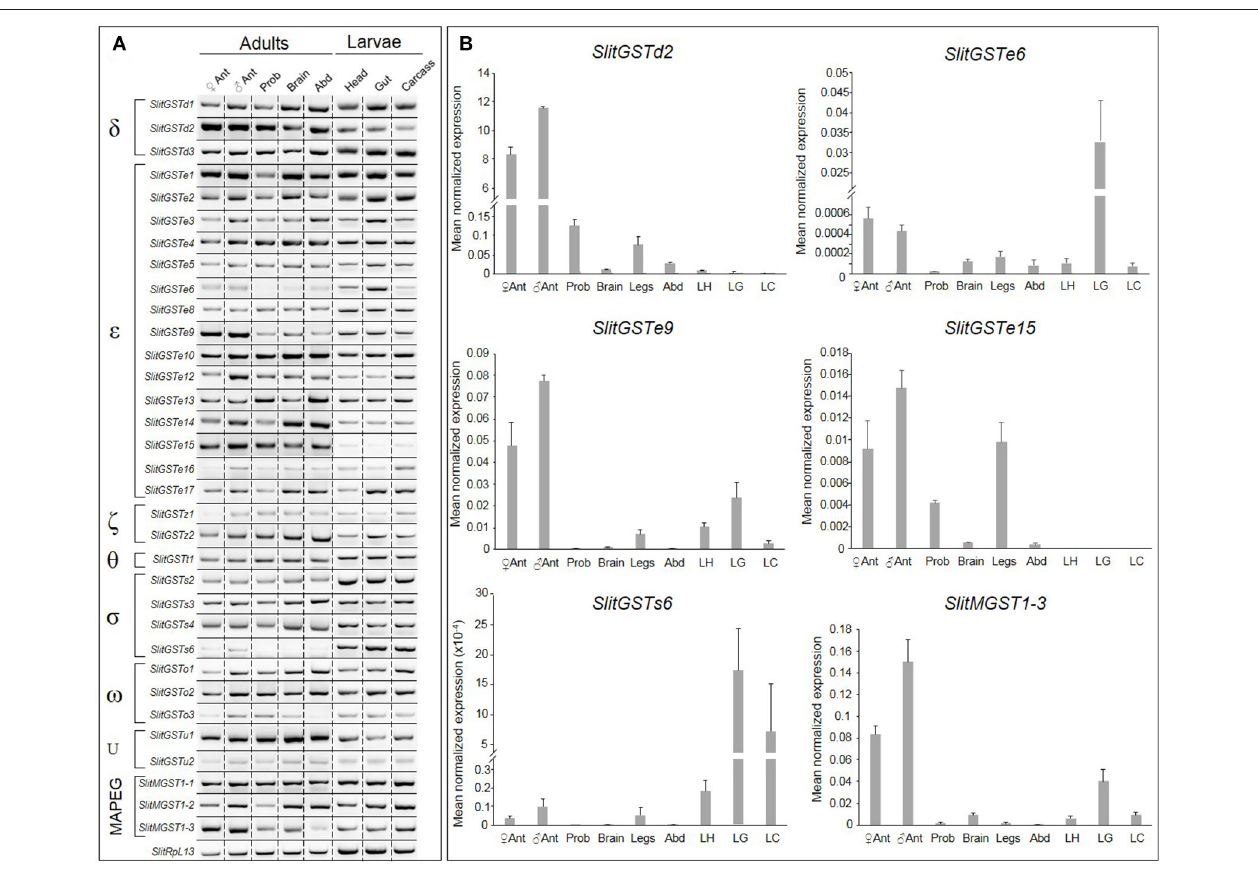
FIGURE 2 | Analysis of Spodoptera littoralis GST expression throughout the body. (A) RT-PCR products visualized on agarose gel. (B) Expression of SlitGSTd2 , SlitGSTe6 SlitGSTe9 , SlitGSTe15 , SlitGSTs6 , and SlitMGST1-3 by qPCR. Data were obtained from triplicate experiments and are given as the Mean ± SD. Templates were from adult female antennae, adult male antennae, proboscis, brains, abdomen and larval heads, guts and carcasses. SlitRpl13 was used as the control